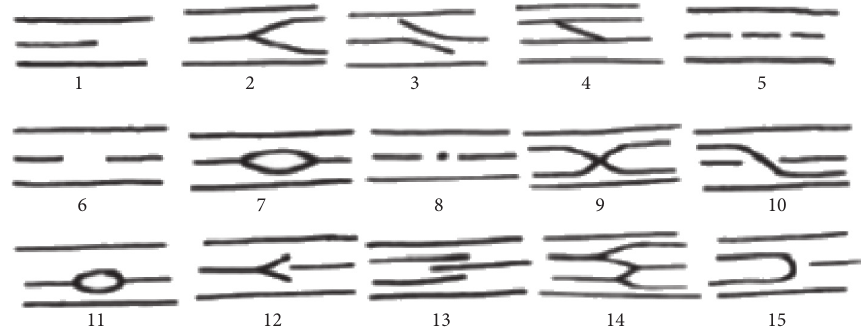
Figure 5: The Guardia Civil database minutiae characteristics [7]. Table 1: Labeling of minutiae